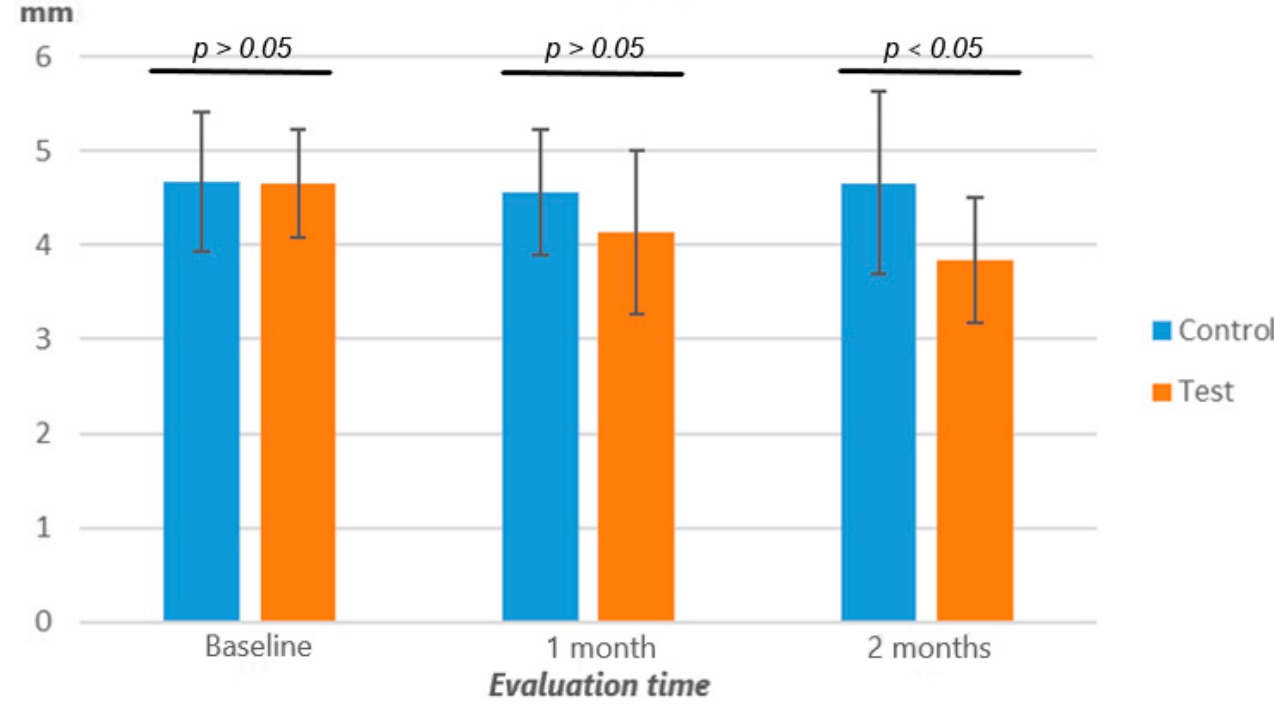
Figure 2. Probing Pocket Depth measurements (mm): the figure shows the absence of intergroup differences at all the evaluation times ( p > 0.05), except at T2 ( p < 0.05). As to intragroup differences, a progressive significant reduction in the index was assessed in the trial group but not in the control one.